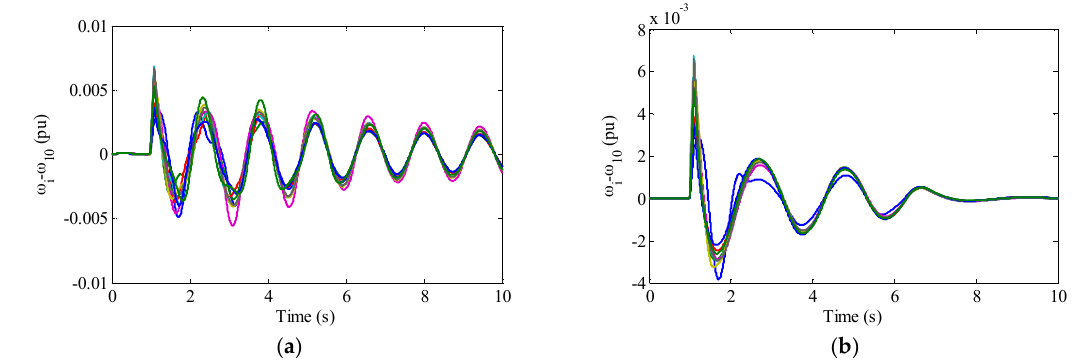
Figure 14. Rotor speed ω i - ω 10 response against a short circuit under operating condition 2. ( a ) Conventional PID governor controller; ( b ) Nonlinear synergetic governor controller.